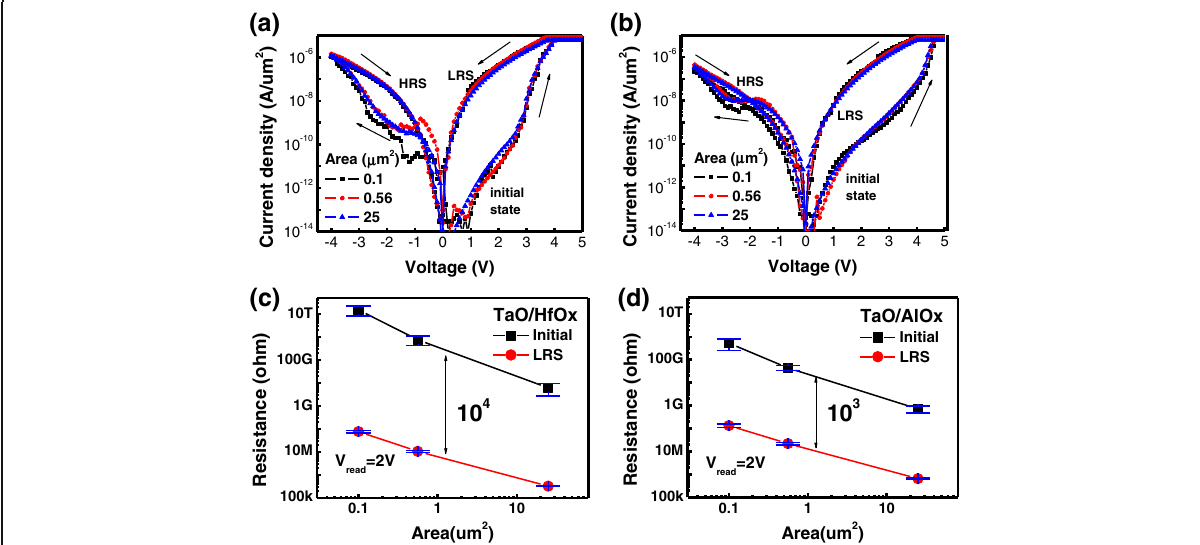
Fig. 2 Current density with voltage plot of a TaO/HfO x devices with different cell sizes. b TaO/AlO x devices with different cell sizes. The resistance versus the area plot of c a TaO/HfO x device and d a TaO/AlO x device. Both plots contain the IRS and LRS with reading voltage = 2 V. Each data point provides the average of 10 devices and the corresponding standard deviation